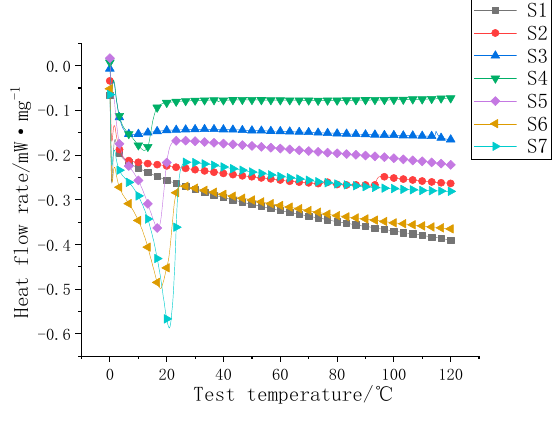
Figure 10. S1–S7 DSC diagrams.